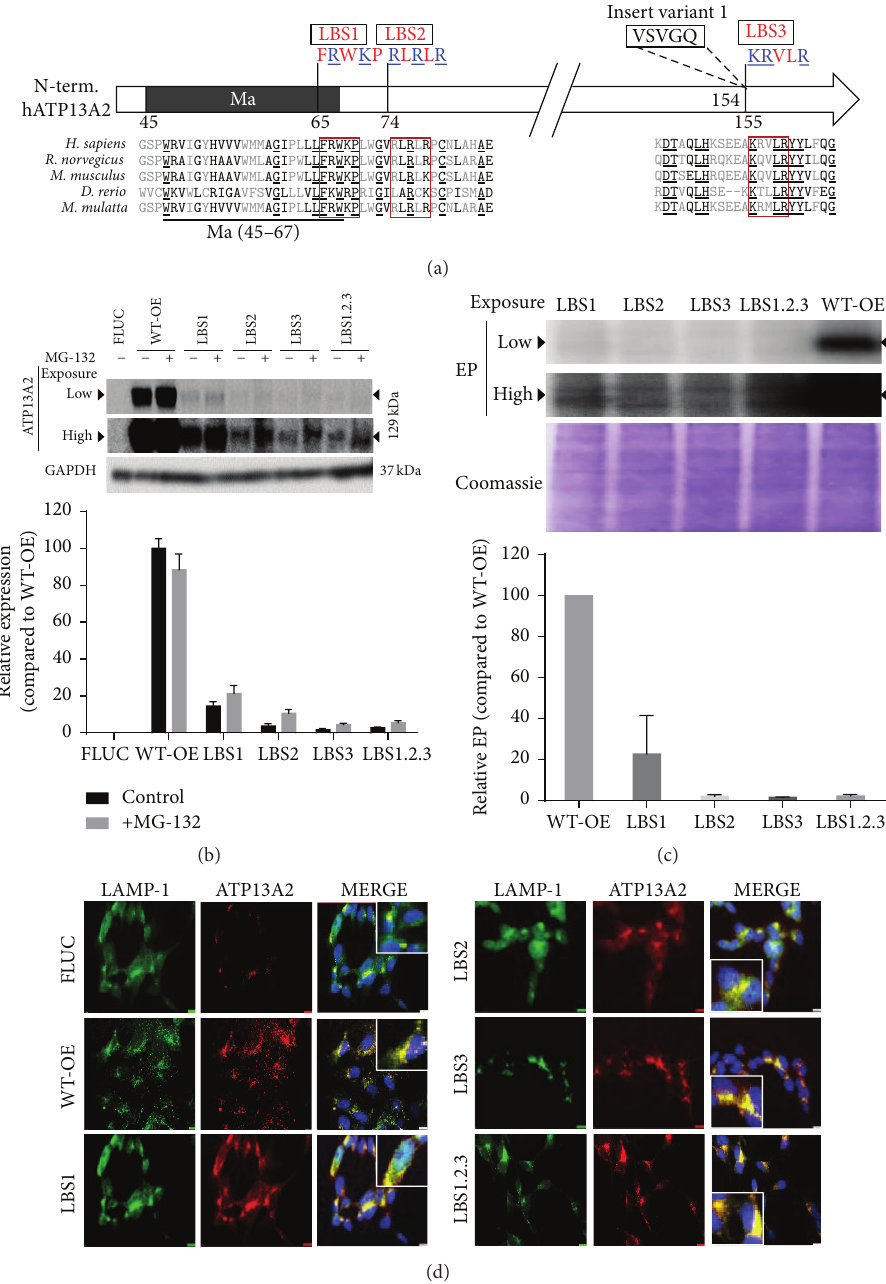
Figure 1: Mutations in the key lipid binding sites of ATP13A2 inhibit activity but not subcellular targeting. (a) Multiple positively charged residues in previously identified lipid binding sites [14] (blue, underlined) were substituted for Ala. LBS3 overlaps with an alternative splicing site rendering an insertion of five additional residues in splice variant 1 of ATP13A2. Ma, membrane-associated region. (b) Expression levels of ATP13A2 were analyzed by immunoblotting with a primary anti-ATP13A2 antibody in comparison to GAPDH as a loading control. Breakdown of LBS mutant proteins by the proteasome was assessed via treatment with the proteasome inhibitor MG-132 (100 𝜇 M) for 6 h. The same gel for the expression of ATP13A2 between cell lines has been provided at both low and high intensities. OE, overexpression. (c) Autophosphorylation assay (EP) on microsomes of ATP13A2 WT or LBS mutant expressing SHSY5Y cells. At the top, the same gel was depicted twice at different exposure times. Below, equal protein loading on the SDS-PAGE gel was confirmed by Coomassie staining. We consider that the double bands visible in LBS2 and LBS3 at longer exposure time are background levels while the actual ATP13A2 related EP band (visible in LBS1 and WT-OE) is located in between, but closer to the double band. Quantification of ATP13A2 expression ((b) ATP13A2/GAPDH) and autophosphorylation levels ((c) EP/Coomassie) are depicted. (d) Expression and localization of endogenous (FLUC), WT-OE, LBS1, LBS2, LBS3, or LBS1.2.3 ATP13A2 were confirmed by colocalization experiments with the lysosomal marker LAMP-1 and captured using Olympus IX73 fluorescent microscope. Representative enlarged images of colocalization for all cell lines have been provided as image inserts. Data are representative of 3 independent experiments. Scale bars represent 10 𝜇